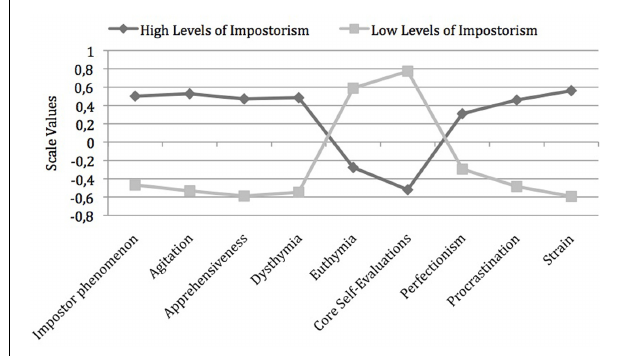
FIGURE 2 | Cluster solution based on Ward procedure after optimization with k -means algorithm ( n = 178).